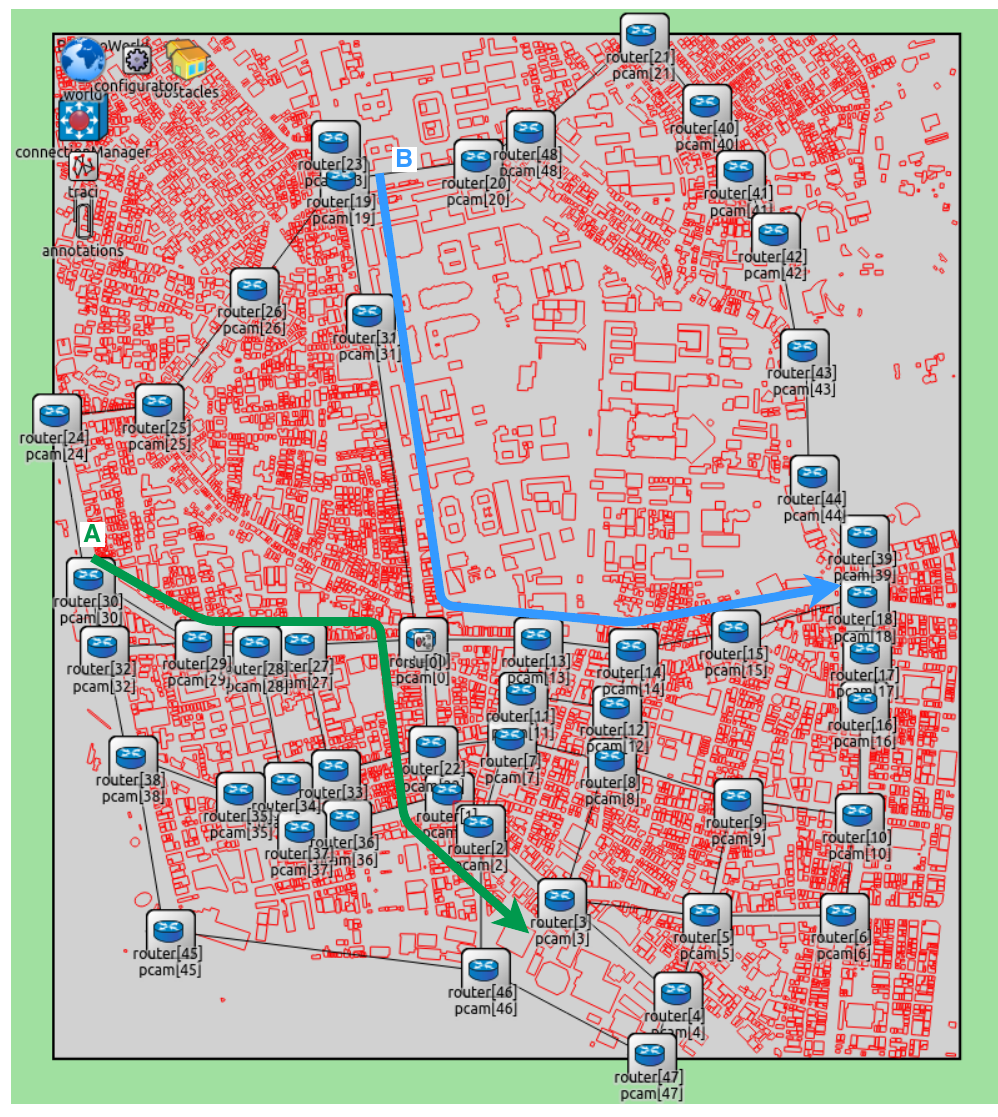
Figure 9. Map of